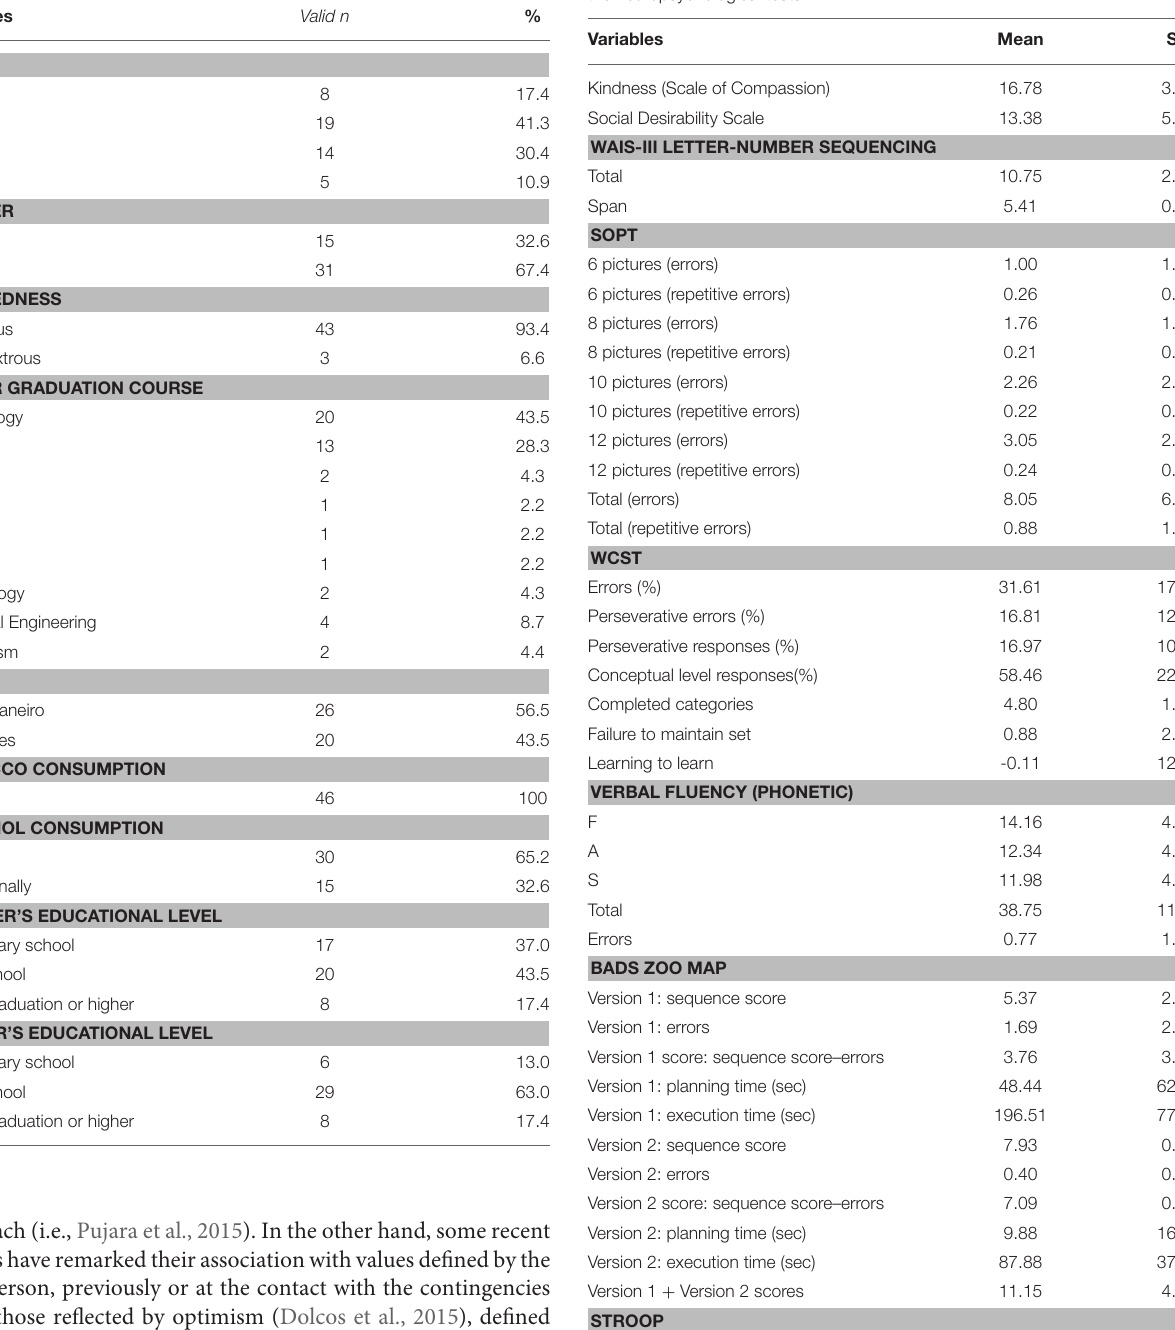
TABLE 1 | Sociodemographic characteristics of the sample. TABLE 2 | Mean and Standard Deviation (SD) for kindness, social desirability and the neuropsychological